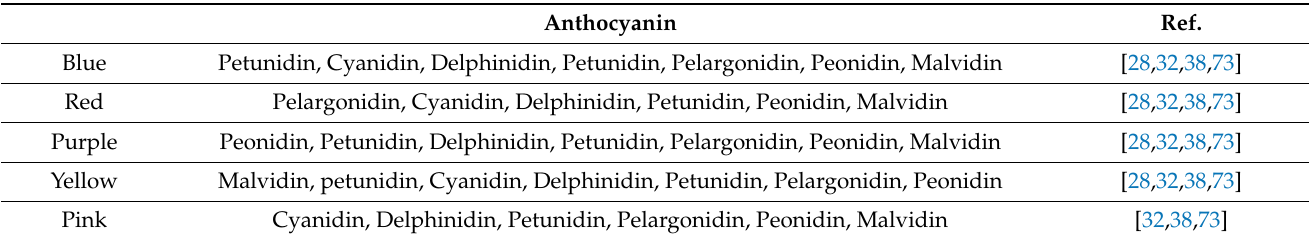
Table 2. Anthocyanins in pigmented potato cultivars. Anthocyanin